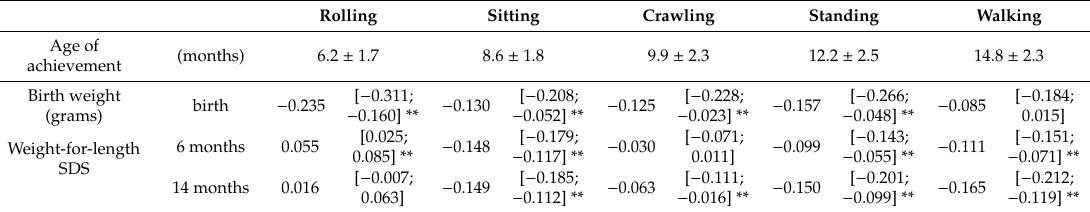
Table 3. Associations between birth weight and weight-for length SDS at 6 and 14 months and motor milestones. Rolling Sitting Crawling Standing